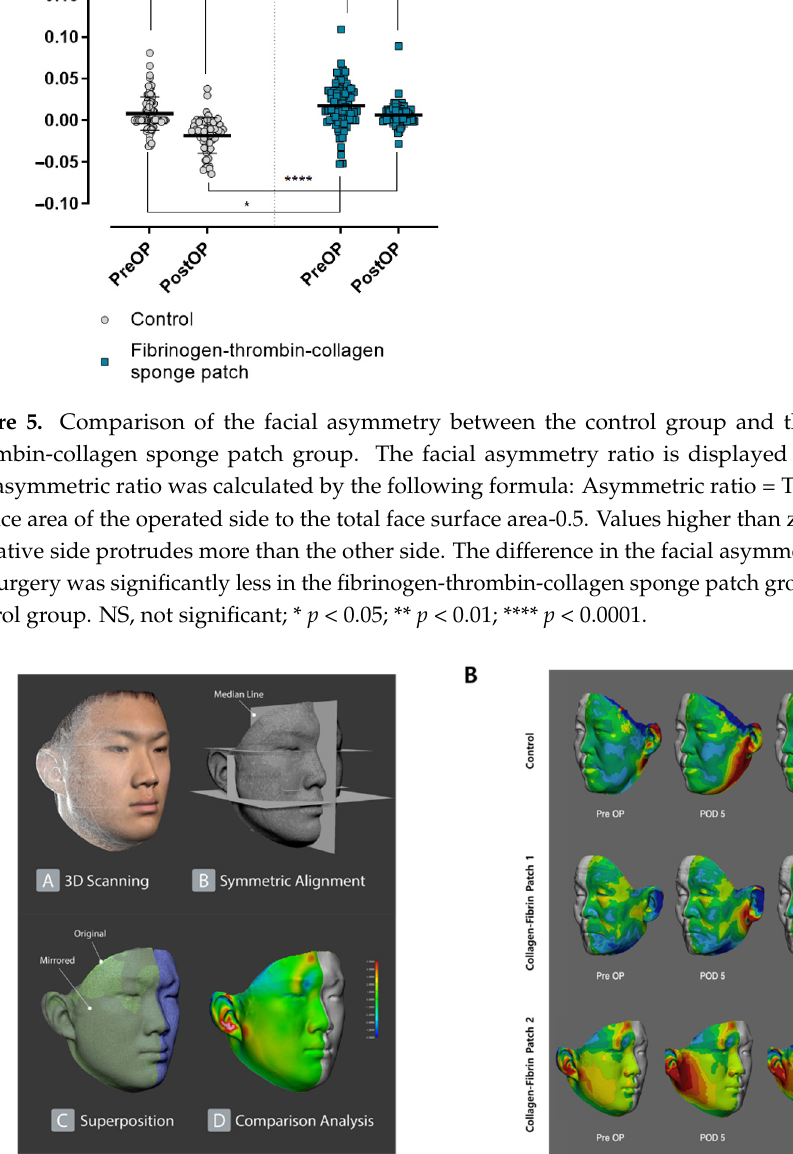
Table 4. Multivariate logistic regression model for drain amount and day until drain removal.